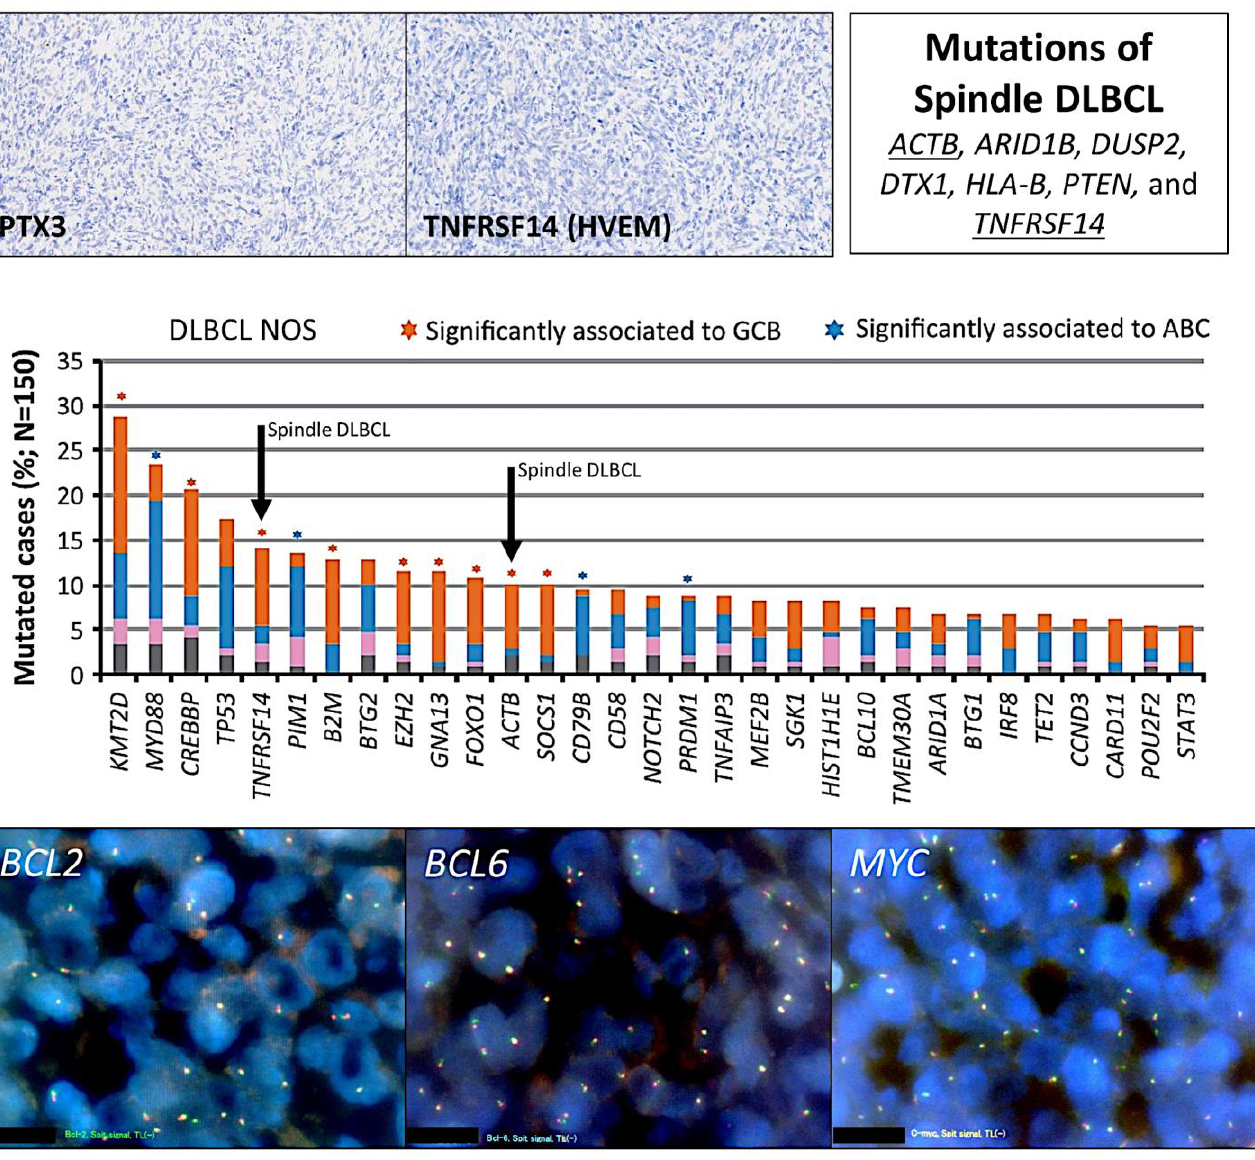
Figure 3. Histological features and mutational profile of the right supraclavicular (lymph) node enlargement. The protein expression of PTX3 and TNFRSF14 was negative. Mutational profiling using an in-house panel of 156 genes of aggressive B-cell lymphomas showed mutations of ACTB , ARID1B , DUSP2 , DTX1 , HLA–B , PTEN , and TNFRSF14 . Notably, mutations of TNFRSF14 and ACTB are usually found in GCB–type diffuse large B-cell lymphoma as described by Karube et al. [22]. Rearrangement of BCL2 , BCL6 , and MYC using DNA split probes were negative by FISH. Based on the NIH National Cancer Institute LymphGen 1.0 classification tool (internet link: https://llmpp.nih.gov/lymphgen/lymphgendataportal.php; accessed on 28